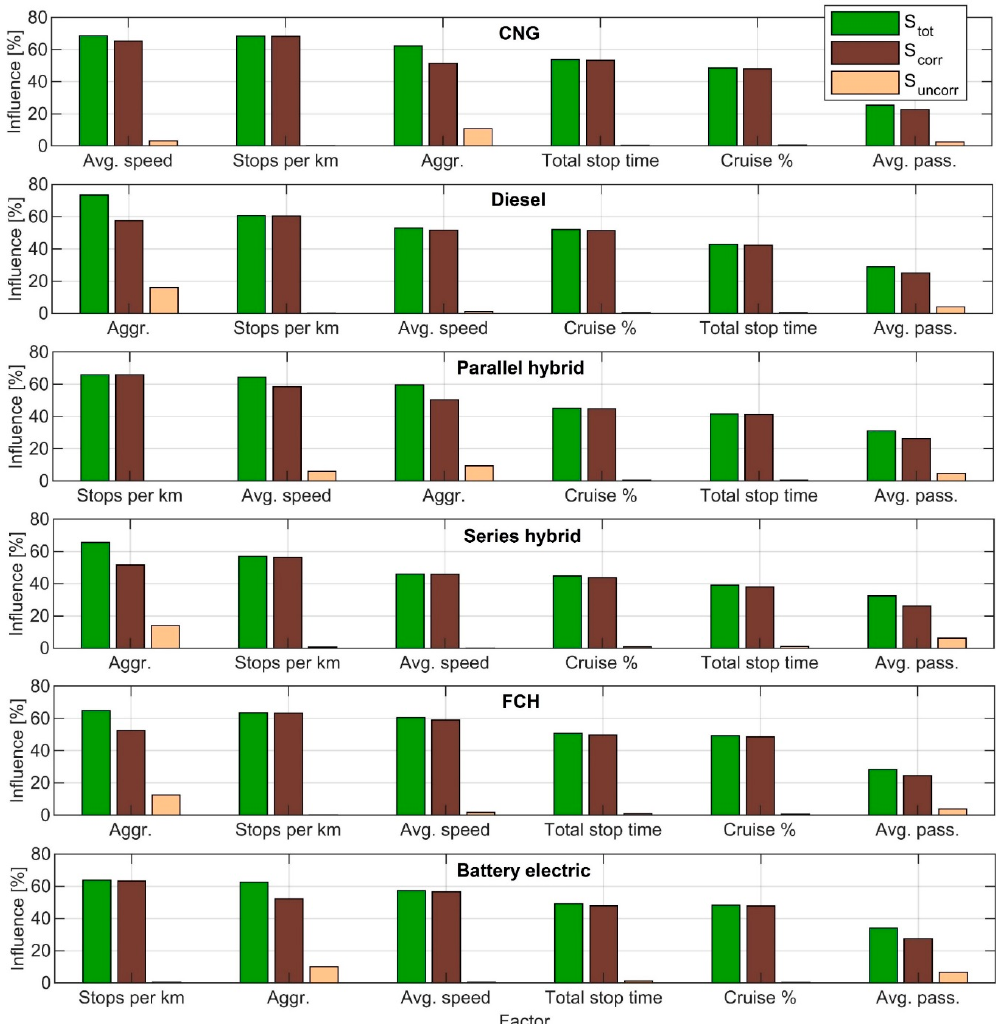
Figure 14. Variance decomposition analysis for the six buses on the synthetic E11 cycles.